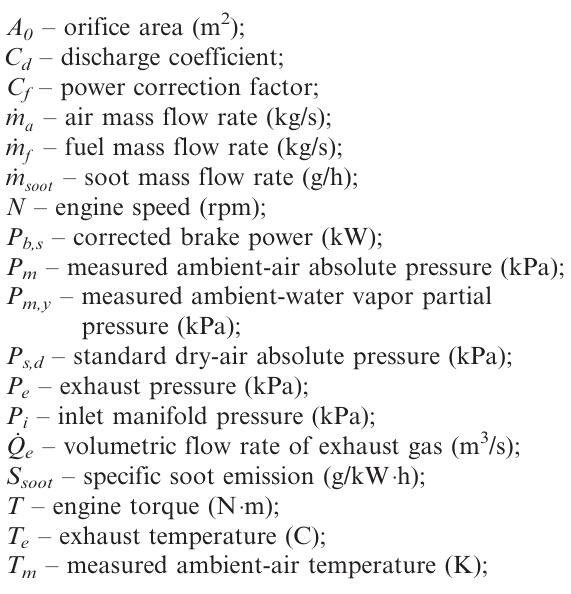
Table 4. Accuracies of the